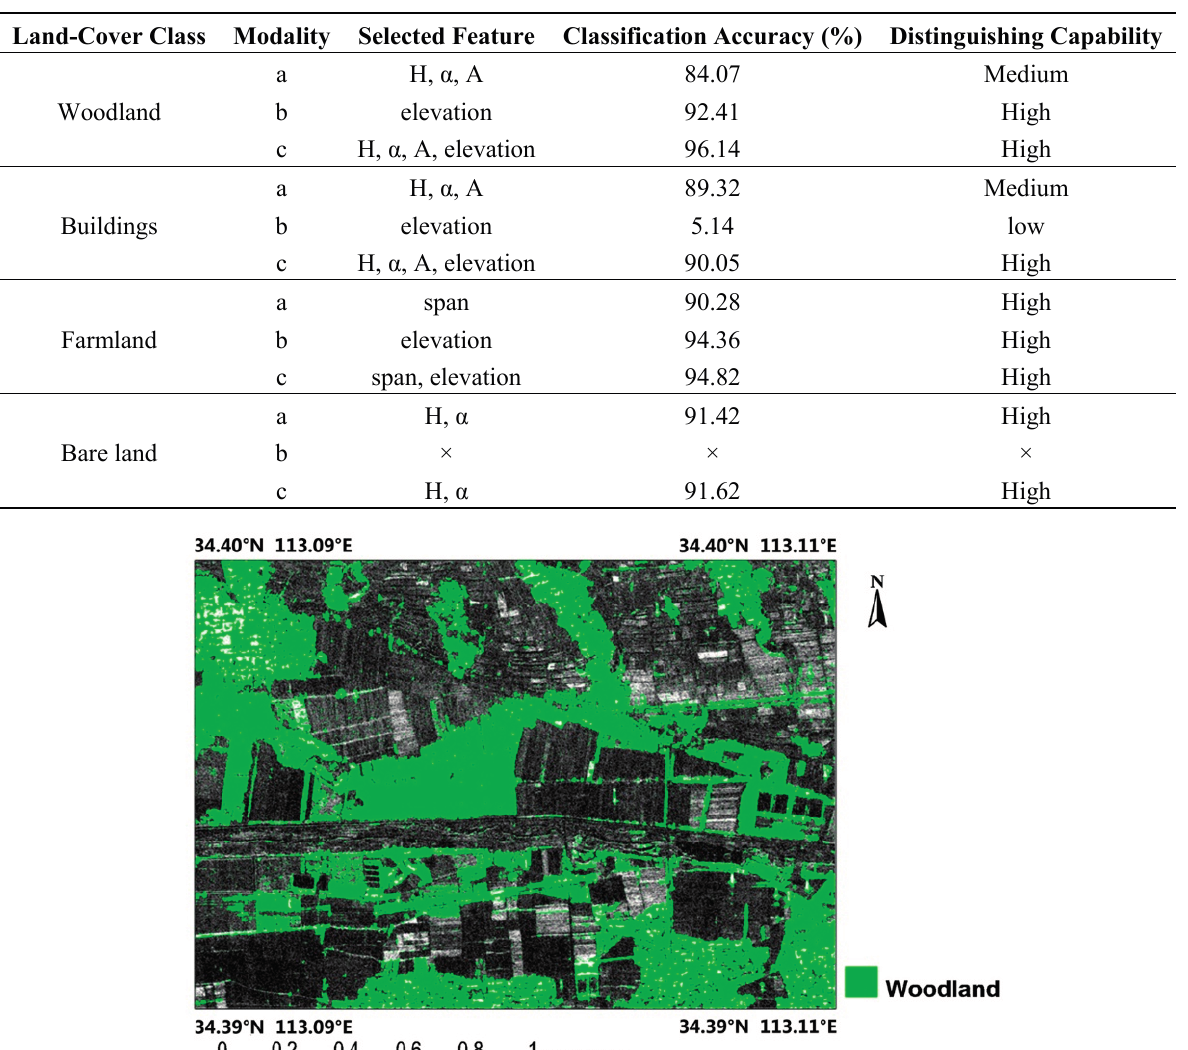
Table 10. The distinguishing capability analysis for each modality.